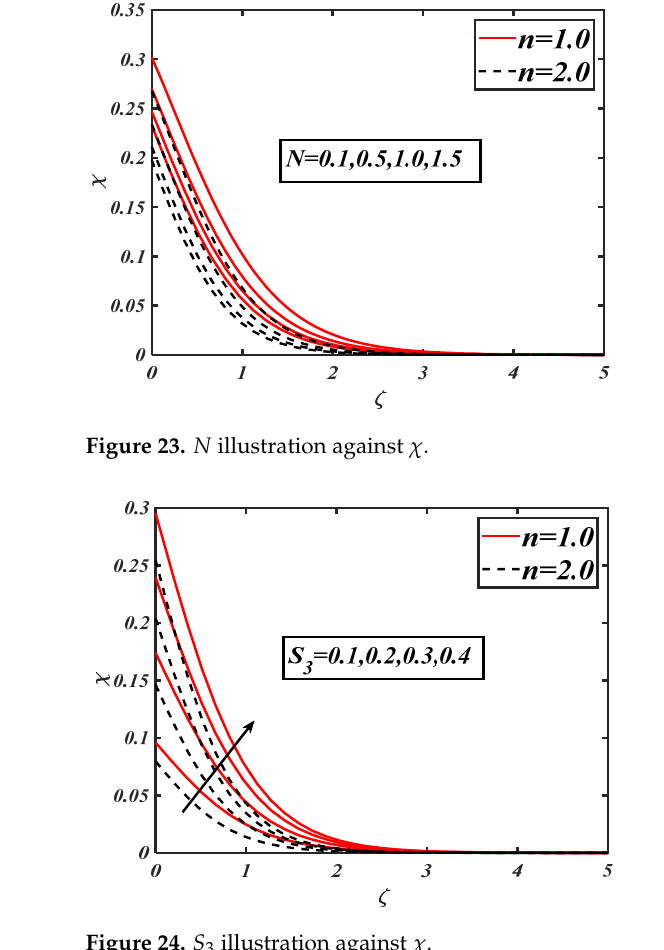
Figure 24. S illustration against χ . 3